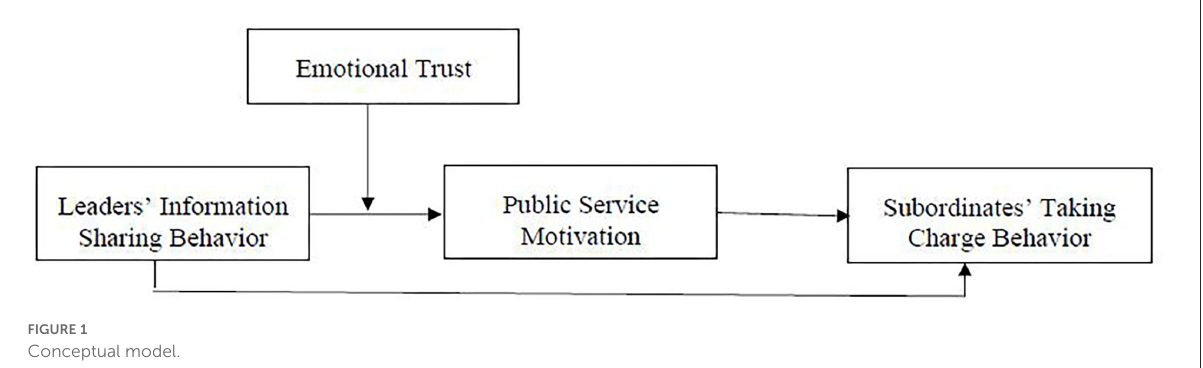
FIGURE1 Conceptual